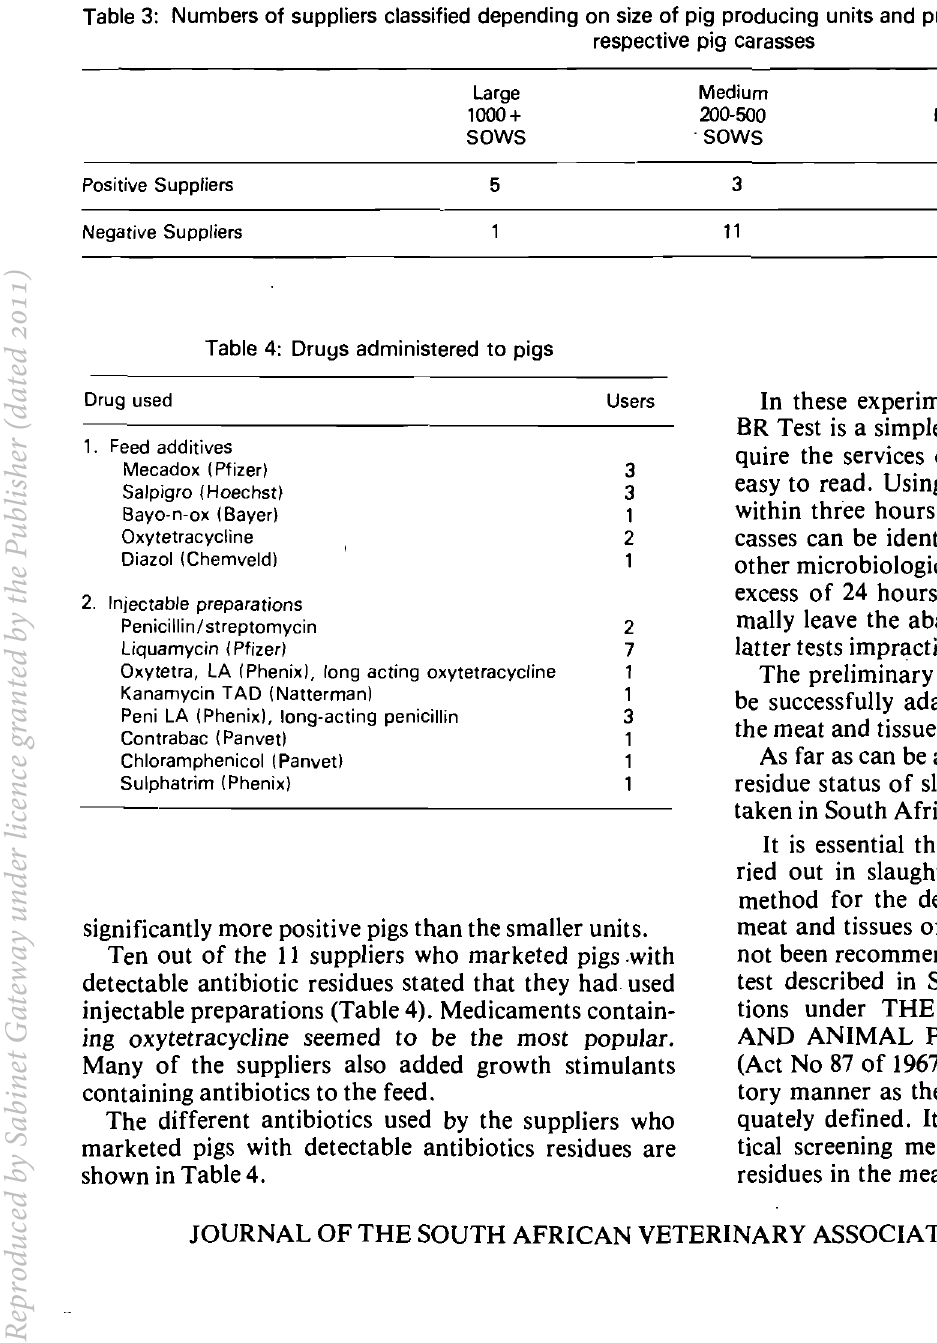
Table 3: Numbers of suppliers classified depending on size of pig producing units and presence/absence of antibiotic residues in